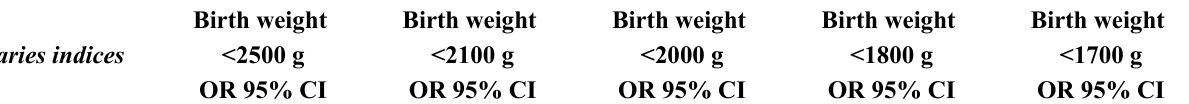
Table 4. Logistic regression analysis with the magnitude of low birth weight as the exposure and caries experience at 19 years of age and total caries increment between 13 and 19 y as an outcome.